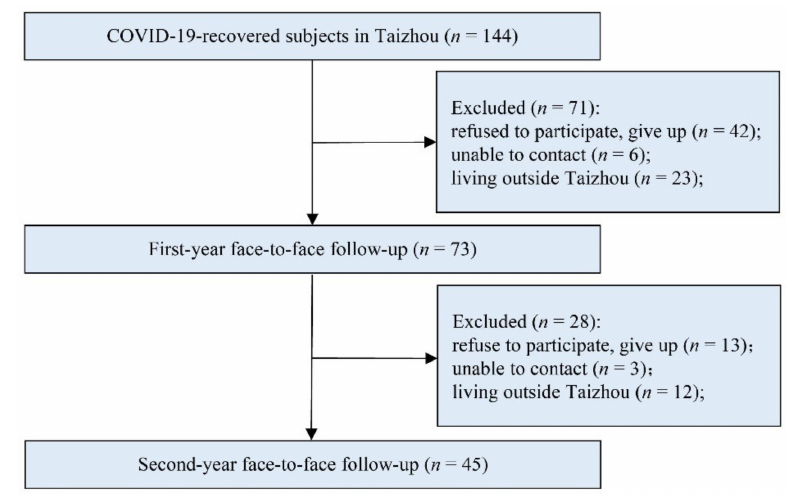
Figure 1. Screening